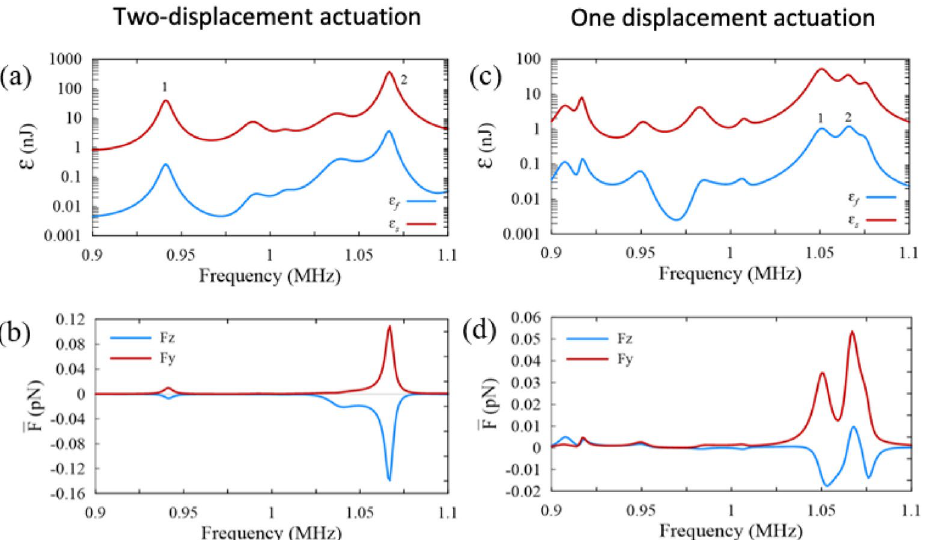
Figure 3. The plot of acoustic energy density and average acoustic radiation force of polydimethylsiloxane (PDMS) microchannels. ( a ) The semi-log plot of the acoustic energy density for the fluid domain (blue curve) and the solid domain (red curve), and ( b ) the average acoustic radiation force in the z direction (blue curve) and in the y direction (red curve) under the two-displacement actuation. ( c ) and ( d ) are the same as ( a ) and ( b ) but under the one-displacement